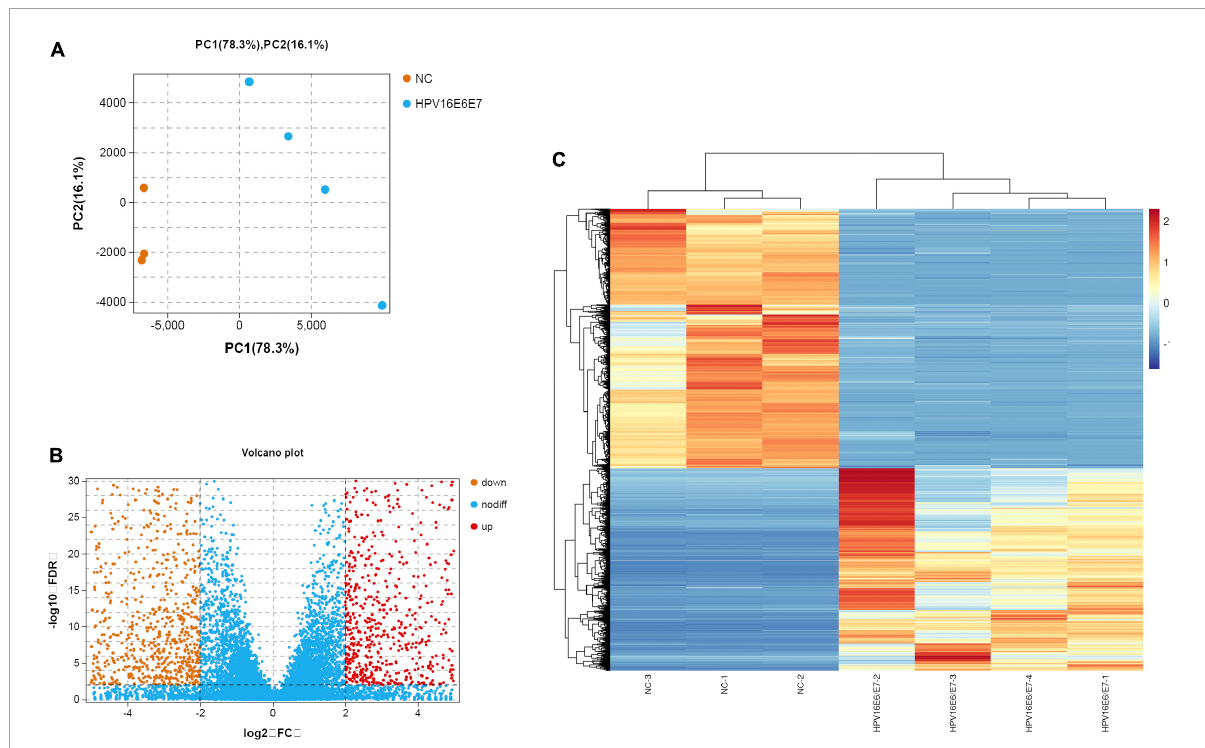
FIGURE3 Overview of the differential mRNA expression between two groups (A) Use R software to carry out PCA, the horizontal and vertical coordinate represent PC1 and PC2 representatively; The distance in the graph reflects the degree of the difference between groups. (B) In the volcano plot, orange and red represent down- and up-regulated genes, respectively, while blue expresses genes that are not significantly different. (C) In the Heat Map, the closer the value of the vertical coordinate to red indicates a greater relative gene expression, and vice